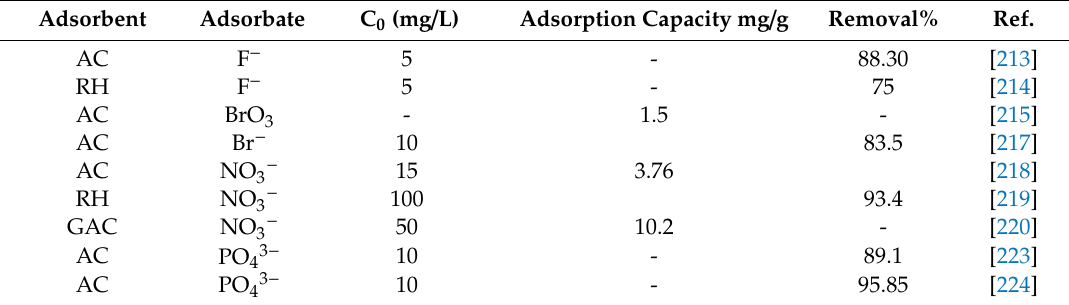
Table 9. Adsorption capacities of inorganic anions by pristine RH, RH ash (RHA), and RH-derived activated carbon